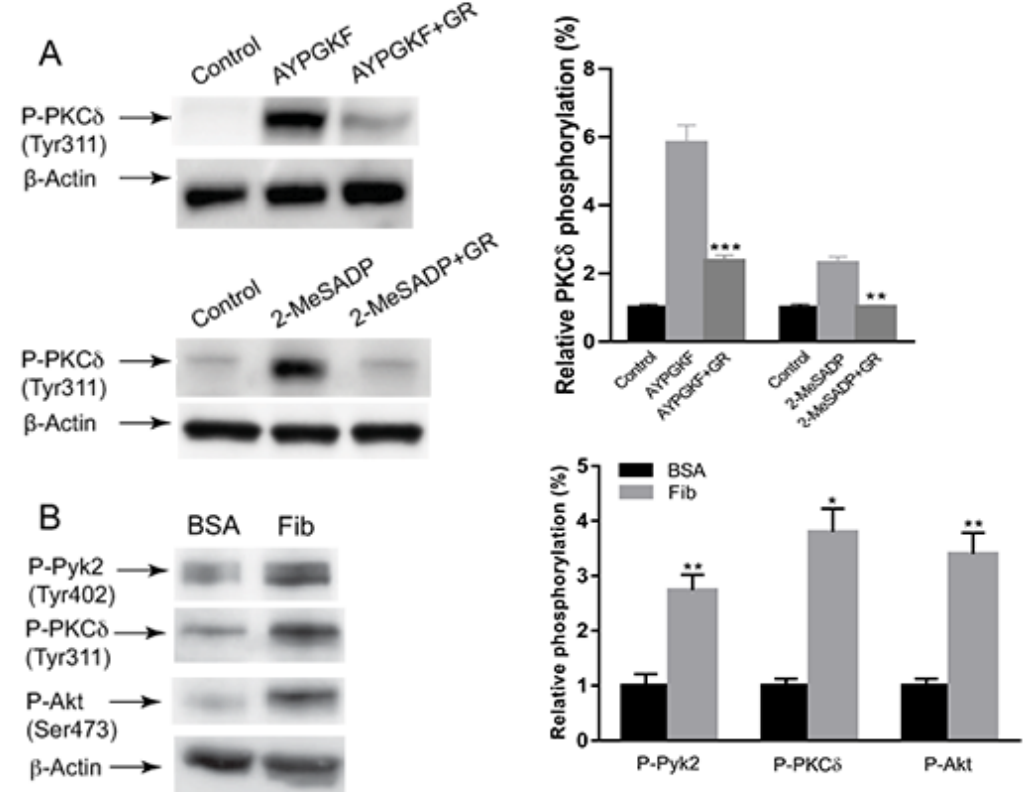
Figure 1. The effect of integrin αIIbβ3 on PKCδ phosphorylation in platelets. ( A ) Washed murine platelets were stimulated at 37 C with 200 µM AYPGKF and 100 nM 2-MeSADP in the presence and absence of 1 µM GR144053 and probed with antibodies indicated. The blots are representative of three independent experiments and are presented as mean ± standard error (SE). ** p < 0.01 and *** p < 0.005. ( B ) Platelets were plated on either bovine serum albumin (BSA) (5 mg/mL) or fibrinogen (100 μg/mL) for 45 min, and lysates were probed with anti-phospho-Pyk2 (Tyr402), anti-phospho-PKCδ (Tyr311), anti-phospho-Akt (Ser473) or anti-β-actin (lane loading control) antibodies by western blotting. The blots shown are representative of three independent experiments and are presented as mean ± SE. * p < 0.05 and ** p < 0.01.